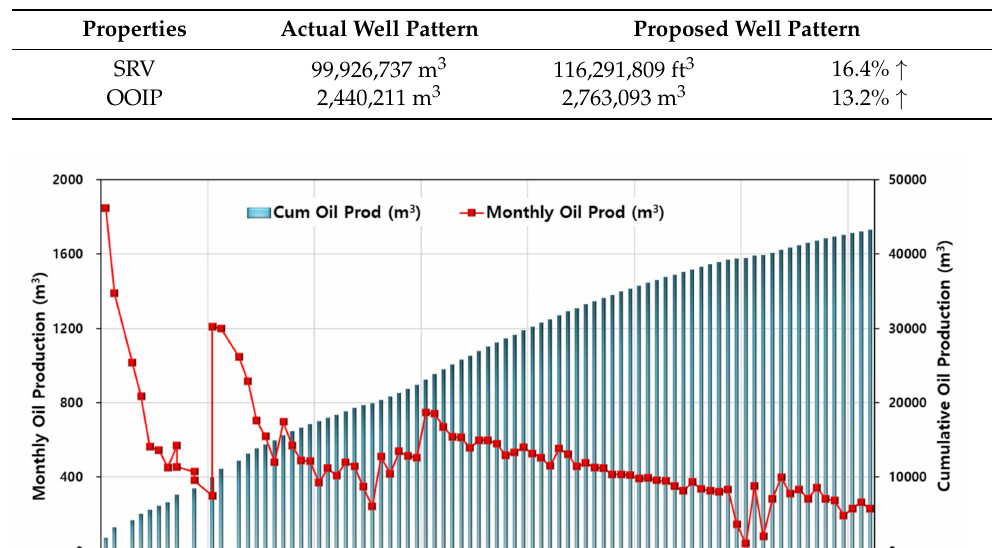
Table 5. SRV and original oil in place (OOIP) results for “Actual Well Pattern” and “Proposed Well Pattern”.